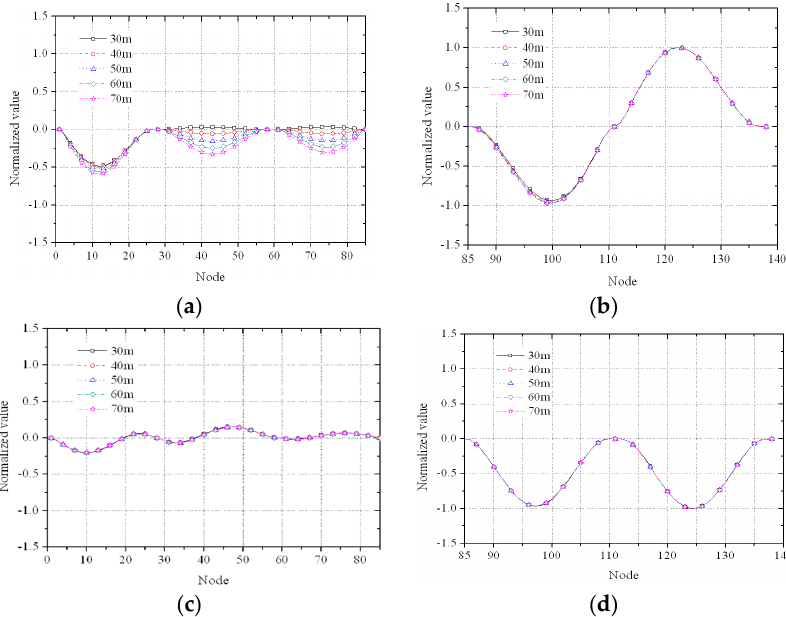
Figure 7. Mode shapes of the irregularly-shaped bridge with different ramp radii. ( a ) Third mode shape (main bridge); ( b ) Third mode shape (ramp); ( c ) Fifth mode shape (main bridge); ( d ) Fifth mode shape (ramp).